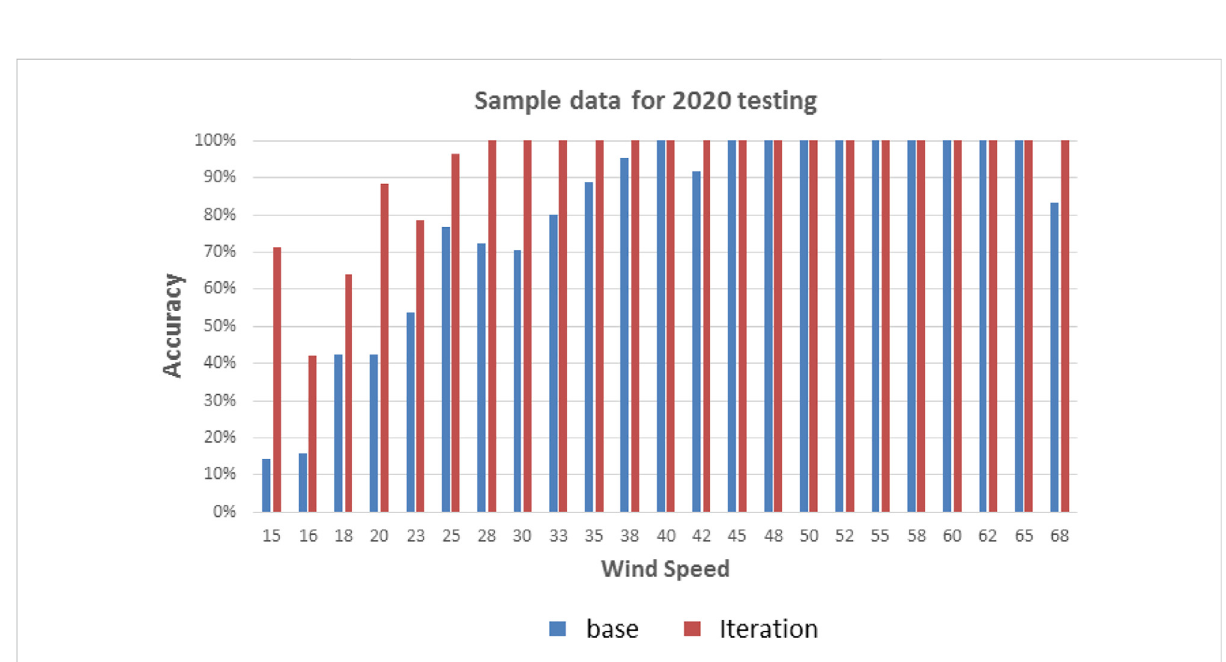
FIGURE 2 Vortex recognition rate test results (blue columns represent non-iterative algorithm; red columns represent iterative